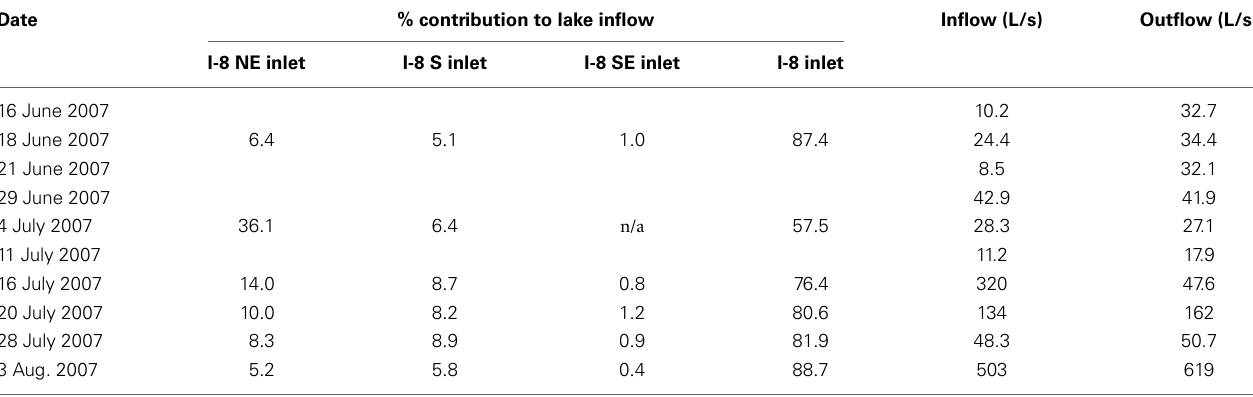
Table 1 | Water contribution to Lake I-8 for summer 2007.